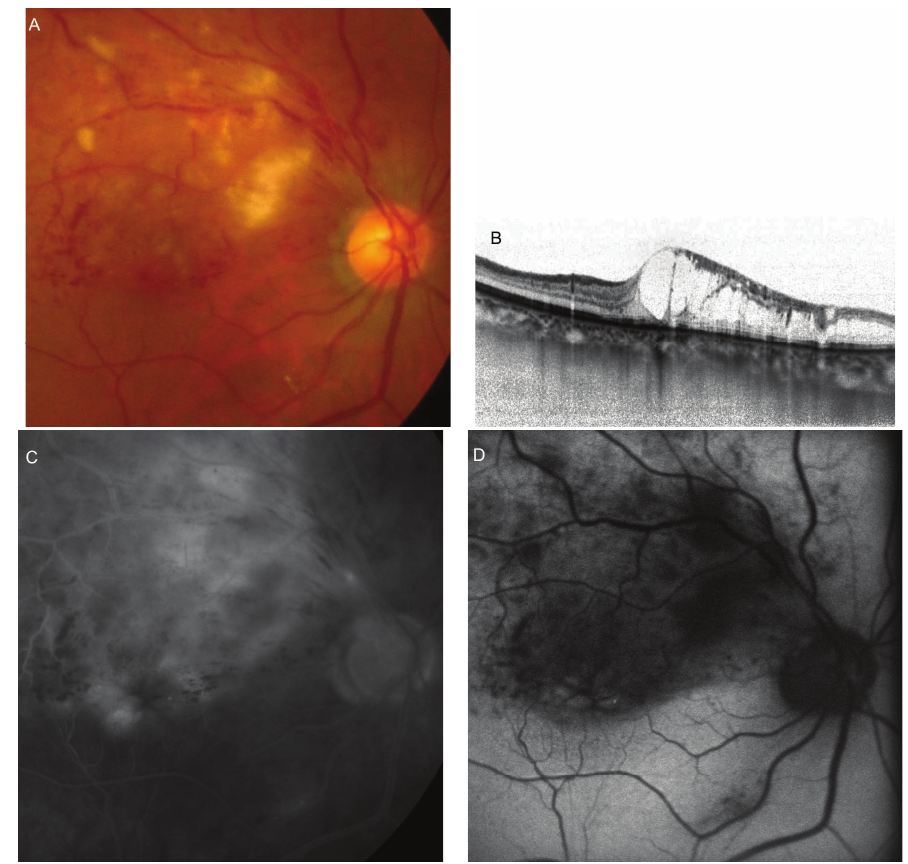
Figure 1: Fundus photograph, OCT, fluorescein angiograph, and autofluorescence images for Patient 1 (a 56-year-old man). A color fundus photograph obtained at the first visit showed an upper temporal vein occlusion in the right eye (A). The best-corrected visual acuity in his right eye was 0.3. A “cotton wool” patch was noticed in the a ff ected area. OCT and fluorescein angiography revealed cystoid macular edema (B). Fluorescein angiography showed a petaloid-shaped hyperfluorescence at the fovea (C). Fundus autofluorescence revealed petaloid autofluorescence corresponding to a cystoid space at the fovea (D).